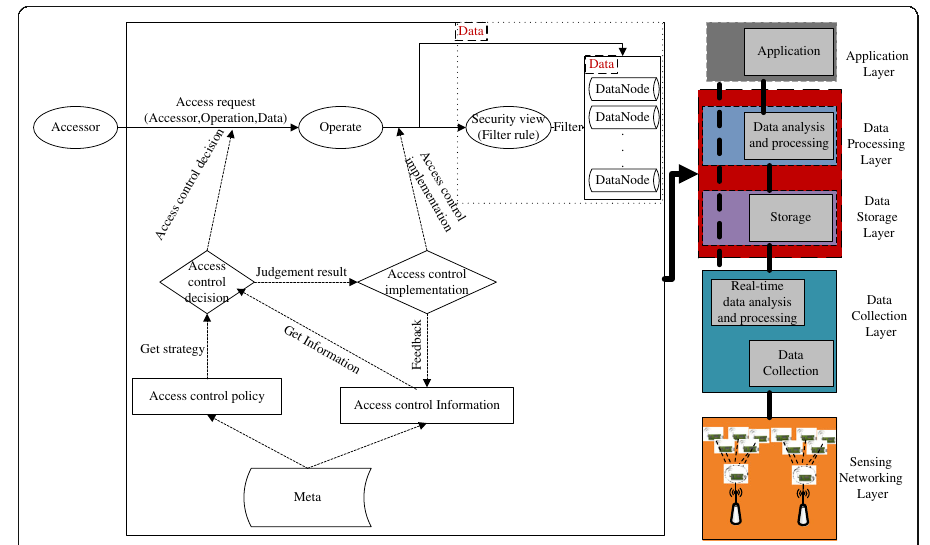
Fig. 1 Big data access control framework in